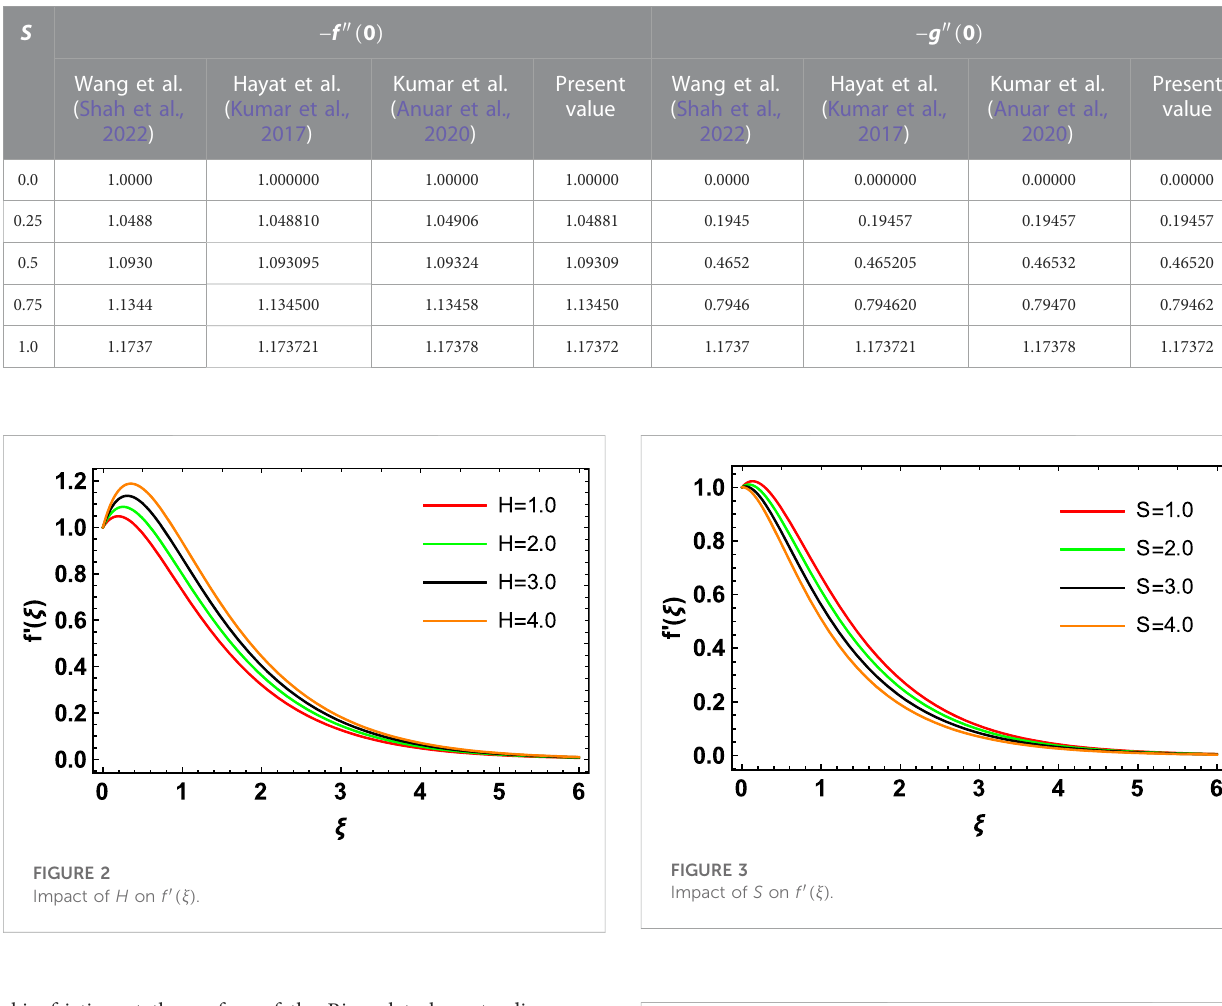
TABLE 2 Comparative analysis of common factors among current and previous results for ϕ 1 (cid:2) ϕ 2 (cid:2) 0 .